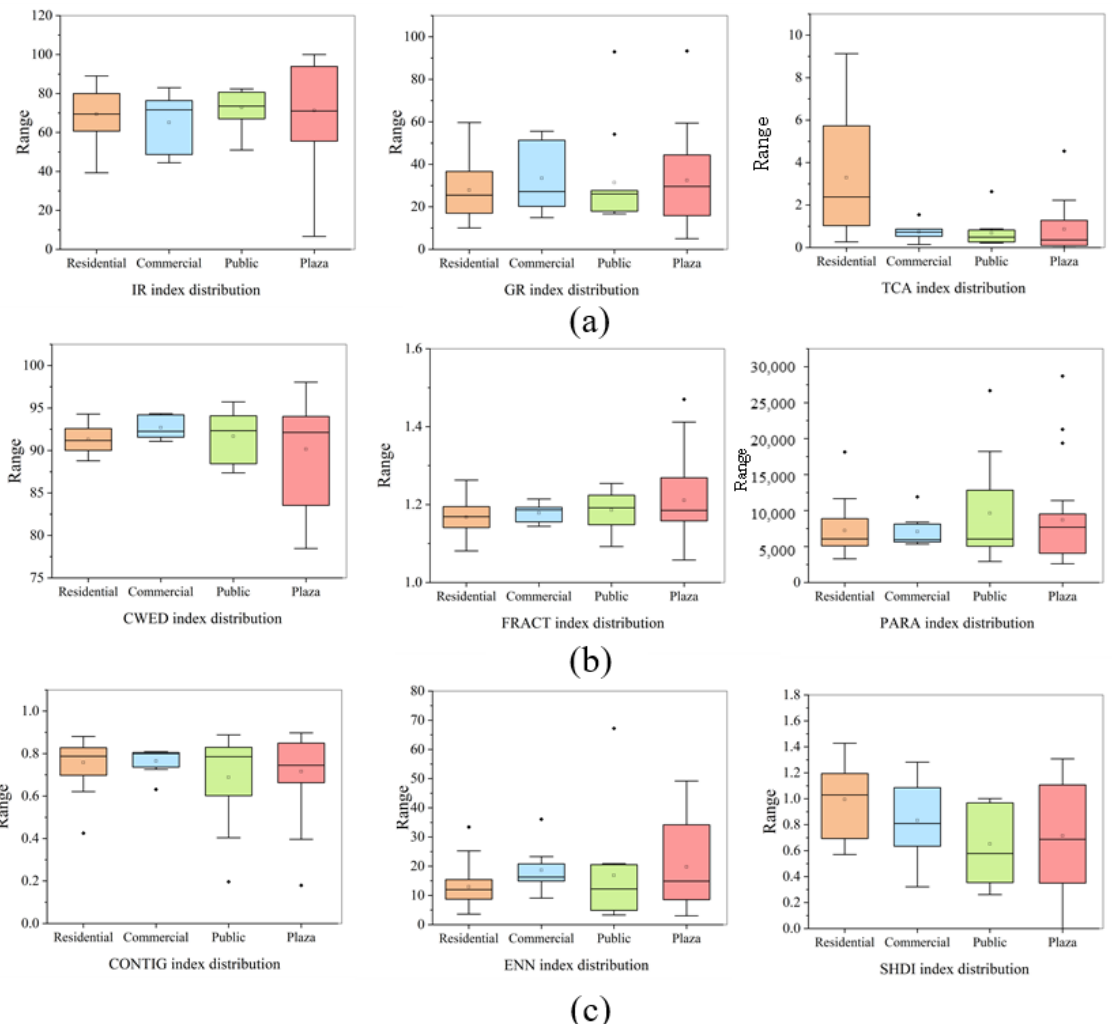
Figure 4. Landscape indices in different functional blocks for the pilot delta region. ( a ) Area factors; ( b ) Shape factors; ( c ) Distribution factors.